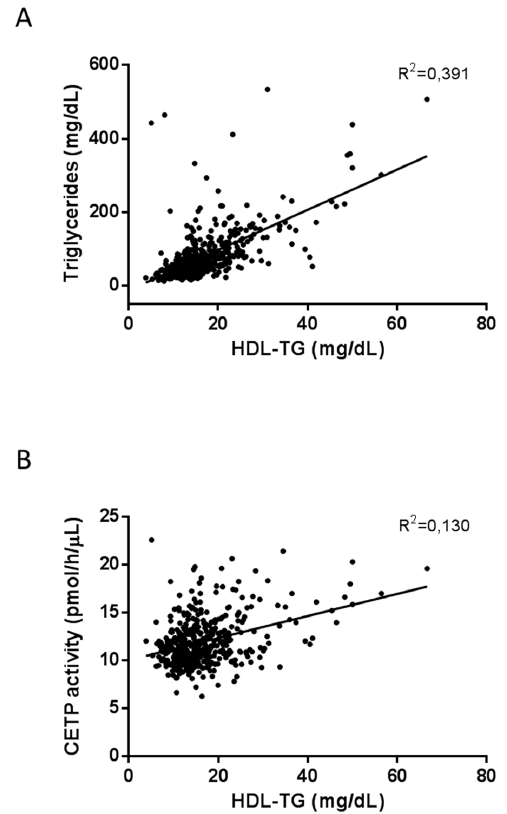
Figure 1. Plots of triglyceride concentrations against HDL-TG ( A ) and CETP activity ( B ). R 2 from the regression analysis are shown.